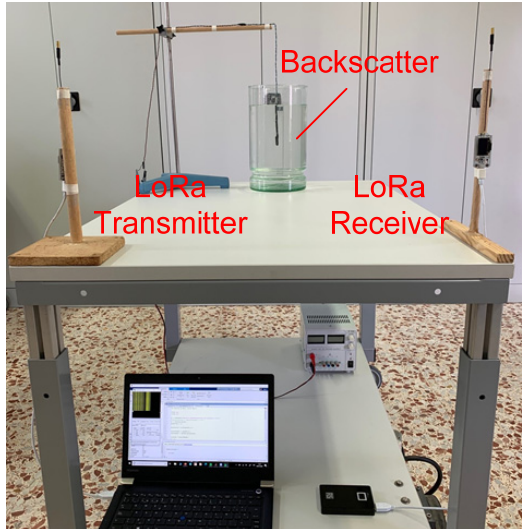
Figure 20. Photograph of the experimental setup in the laboratory.